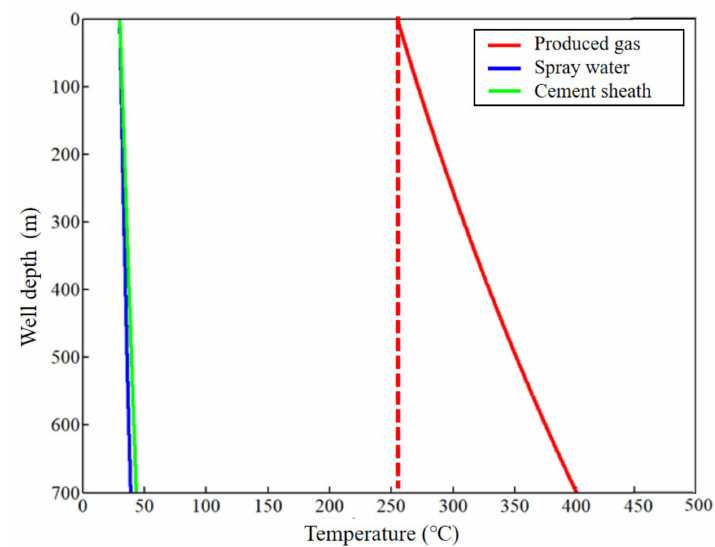
Figure 10. Temperature distribution of concentric water injection